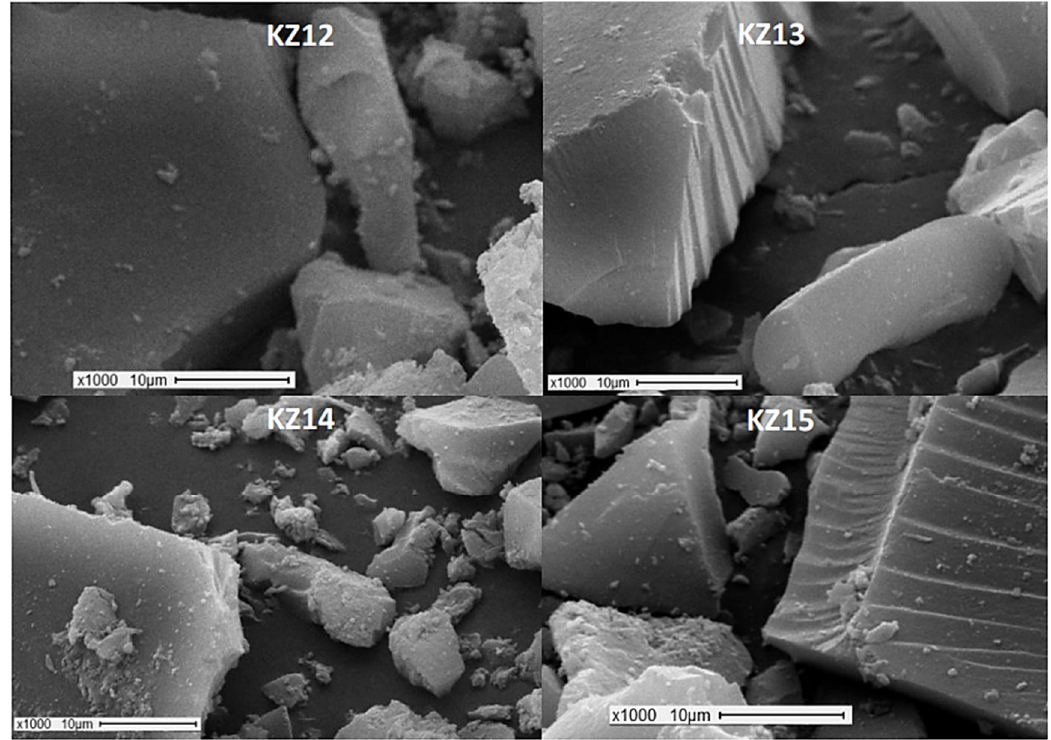
Figure 3. SEM micrographs of synthesized silica-based solid by acid (KZ1, KZ6 and KZ11) and alkali (KZ16) hydrolysis. Magnification ×4000 (scale bar: 2 µm).